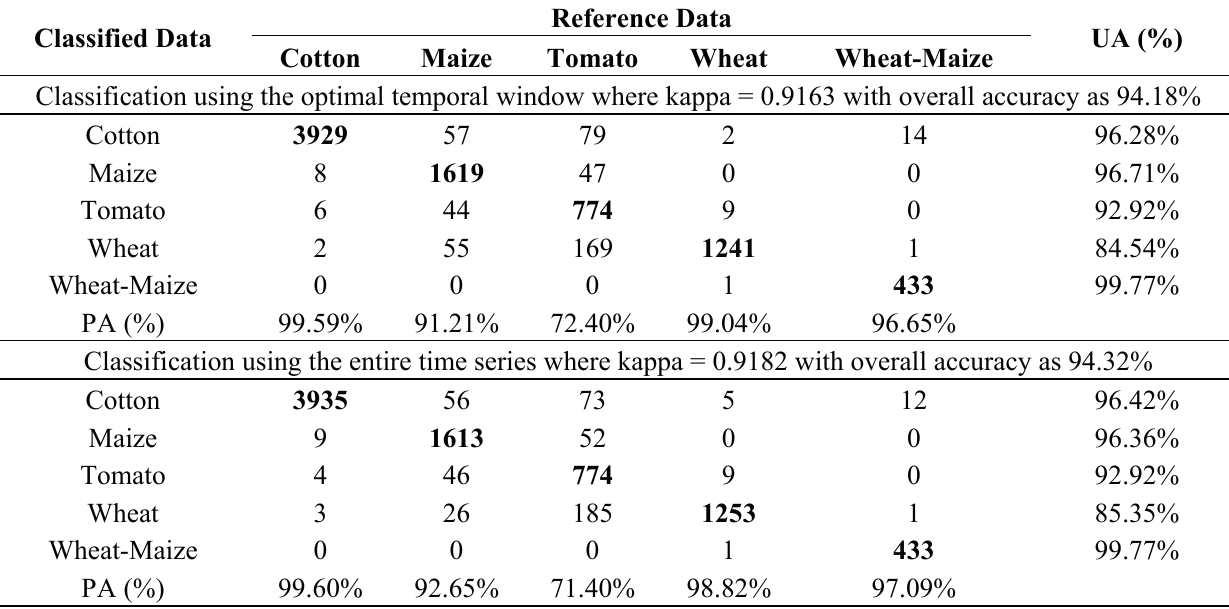
Table 9. Evaluation of crop classification performance in the Manas study area for the entire time series and optimal temporal window using the SVM